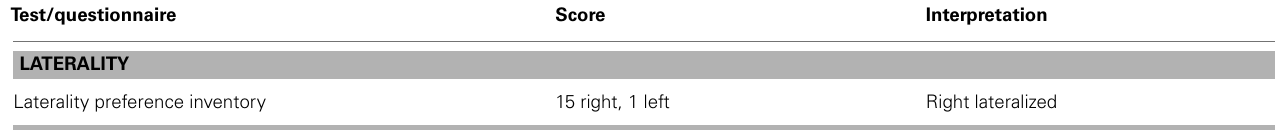
Table 1 | Summary of neuropsychological testing results